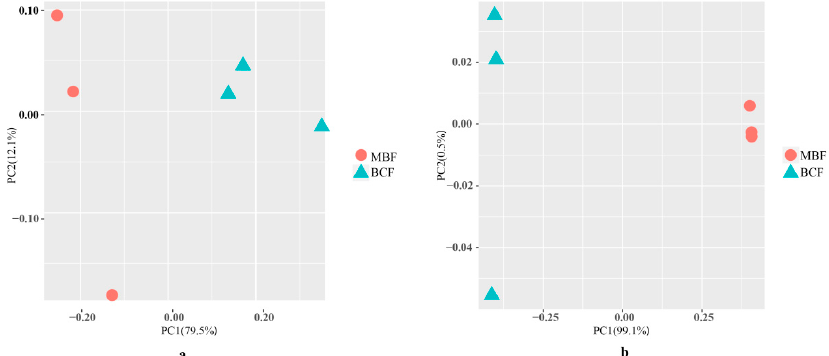
Figure 4. Principal coordinates analysis based on the Bray–Curtis distance for the moso bamboo leaf- associated bacterial ( a ) and fungal ( b ) community structures in the MBF and moso bamboo-chicken farming agroforestry system samples.